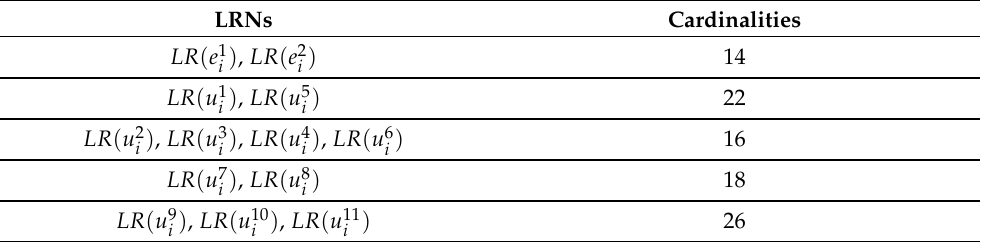
) for 1 ≤ y ≤ 2 and LR ( u z i